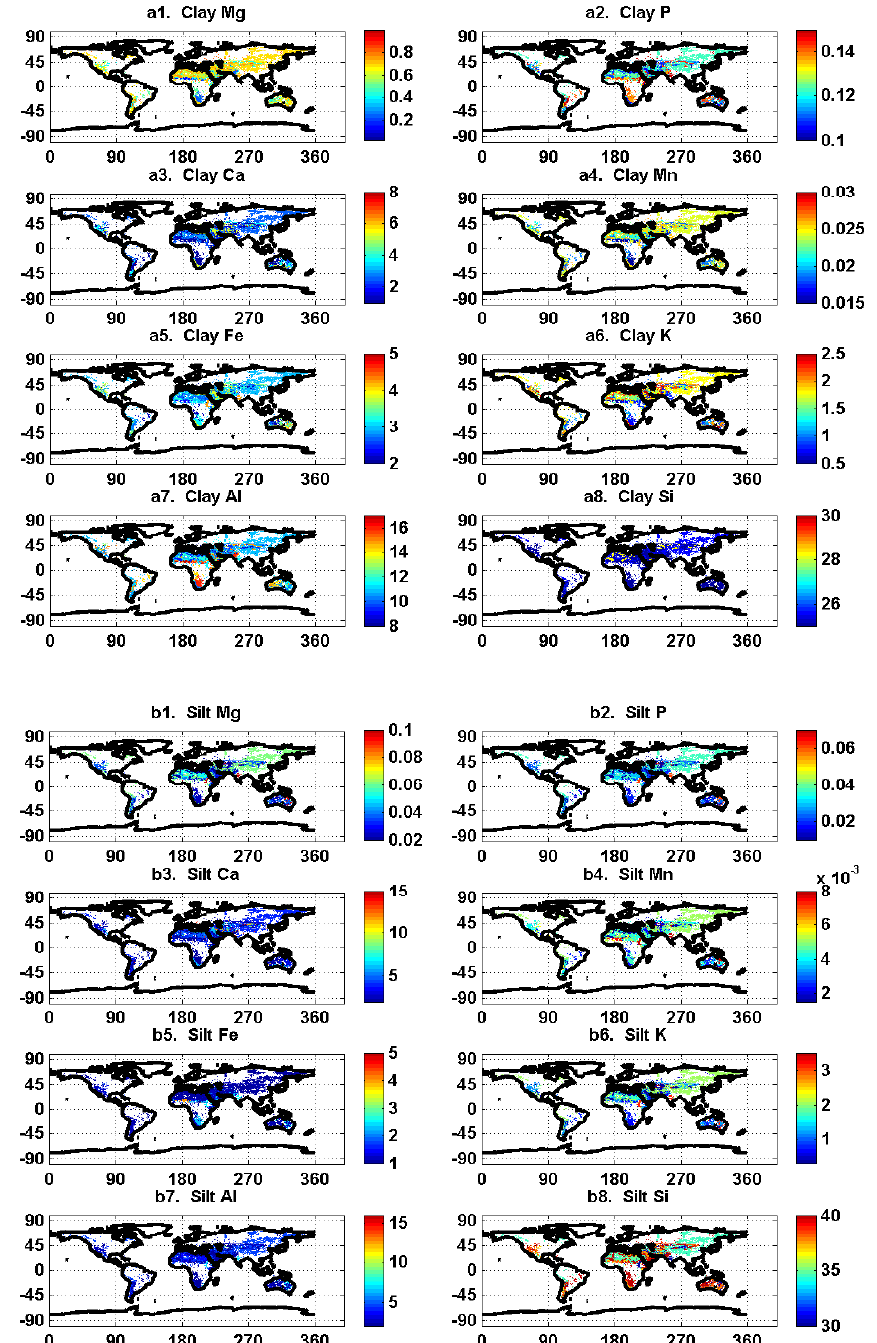
Figure 2. Global elemental distributions (in mass percentage) in a1: Clay Mg, a2: Clay P, a3: Clay Ca, a4: Clay Mn, a5: Clay Fe, a6: Clay K, a7:, Clay Al, a8: Clay Si; b1: Silt Mg, b2: Silt P, b3: Silt Ca, b4: Silt Mn, b5: Silt Fe, b6: Silt K, b7: Silt Al, b8: Silt